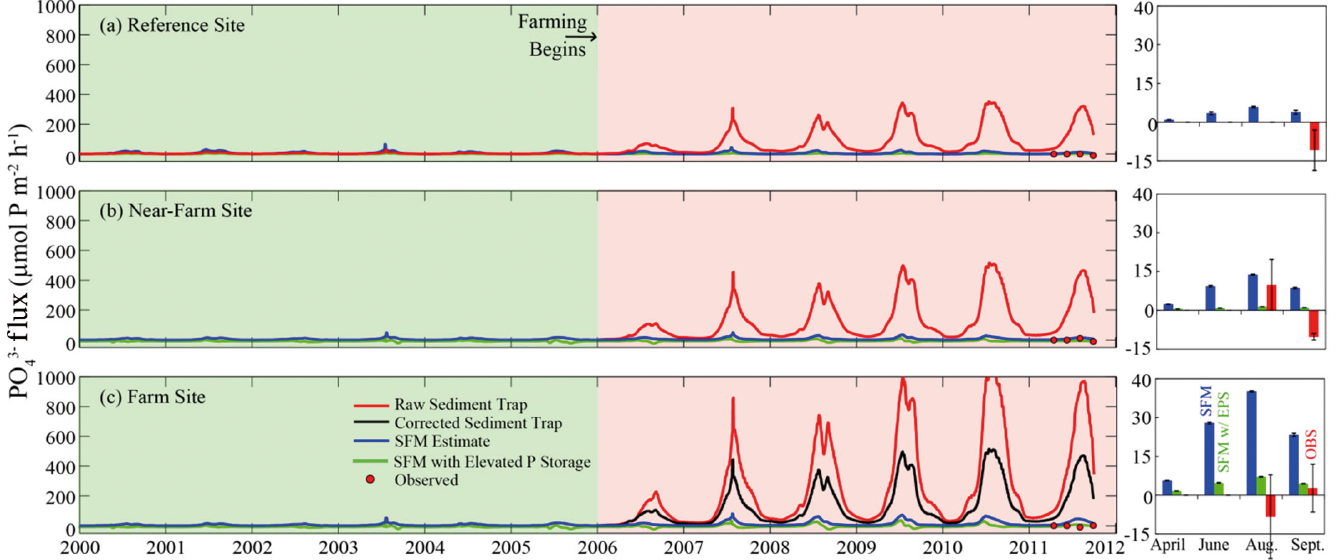
Fig. 9. (Left) Time-series (2000–2011) of modeled (lines) and observed (red circles) PO 43– fluxes at (a) reference, (b) near-farm, and (c) farm sites. Green and red shading indicates pre- and post-oyster farming periods, respectively. Red line: simluation based on uncorrected raw sediment trap estimates, black line: simulation where sediment trap estimates were corrected for re- suspension at the farm site, blue line: simulation where deposition was estimated by sediment flux model (SFM) by fitting depo- sition to the observed sediment–water NH 4+ fluxes, green line: SFM simulation with enhanced sorption capacity in sediments. (Right) OBS, red: observations are compared to the 2 SFM simulations over each month of the experimental study. SFM, blue: model simulations with typical sorption capacity. SFM w/EPS, green: sediment flux models with enhanced sorption